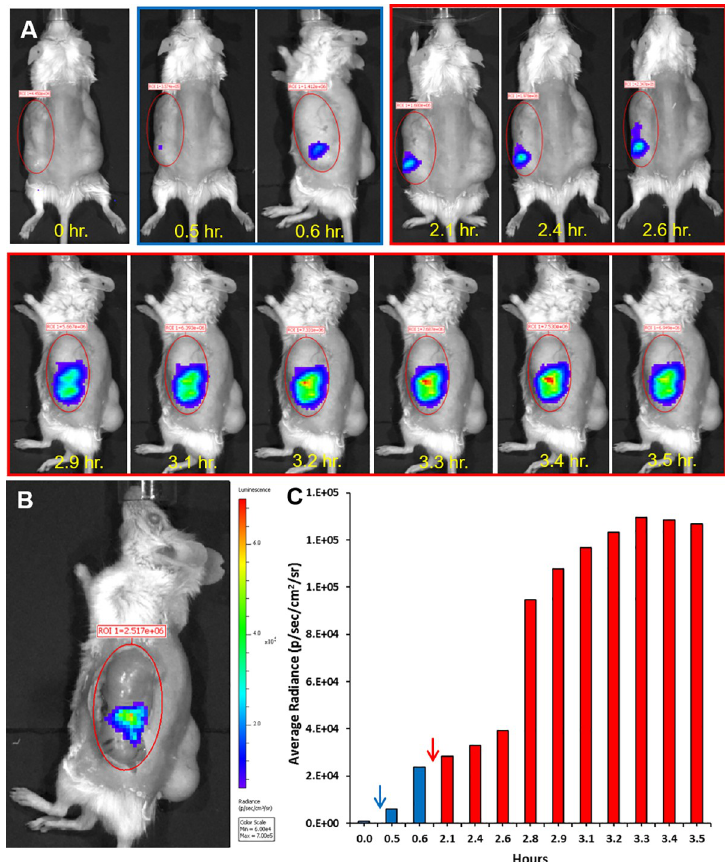
Fig 2. Spatial and temporal activity of NF-kappa-B in steady state and inflamed human gut activated by systemic LPS. Human fetal gut was transplanted into SCID mouse and allowed to develop over 12 weeks. Using lentivirus vector, mature human gut xenografts were transduced with luciferase gene under the control of 5 copies of the NF- κ B response element. Two weeks thereafter, luminescence intravital imaging was performed using cooled CCD optical macroscopic imaging system (IVIS Lumina Series III, PerkinElmer Inc., MA USA) and the time course of the luminescence activity before activation (blue frame in A) and after activation (red frames in A) are presented. To quantify the measured light, images were analyzed using Living Image software (version 4.4, Caliper LifeSciences, MA, USA), equal regions of interest (ROI) were defined over the subcutaneous human gut xenografts (red ellipses in A-B) and the optical signal intensity was expressed as photon flux in units of photons/s/cm2/steradian (color scale in B and bar graph in C). While no luminescence signal was observed before systemic injection of D-luciferin (time point 0 hr. in upper left panel in A and bar graph in C), steady state focal activity was visible (blue frame in A and blue bars in C) after luciferin injection (blue arrow in C). The focal activity of NF- κ B was discretely activated (red frames in A and red bars in C) following systemic injection of LPS (1 mg/kg) (red arrow in C). To further verify the origin of luminescence signal, the skin above the xenograft was removed and the exposed xenograft was imaged in the live mouse (B). Representative results of one experiment out of five similar